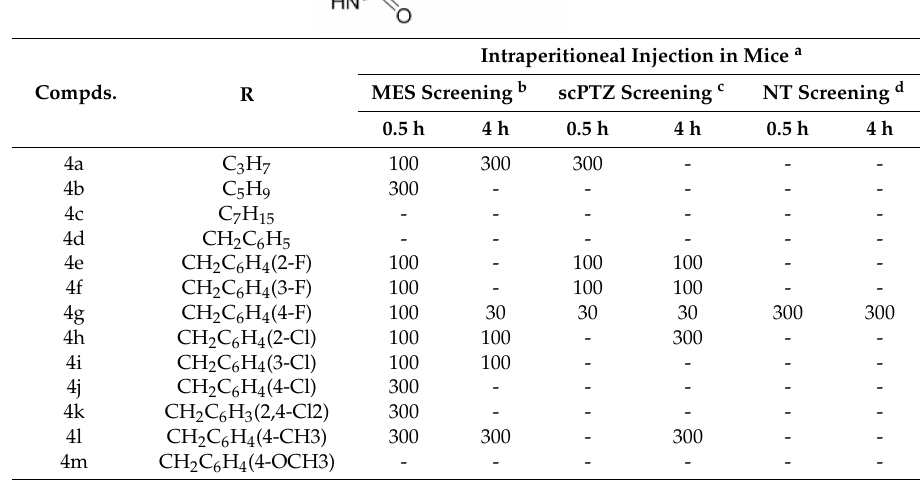
Table 1. Anticonvulsant activity and neurotoxicity of compounds 4a – m administered intraperitoneally to mice.